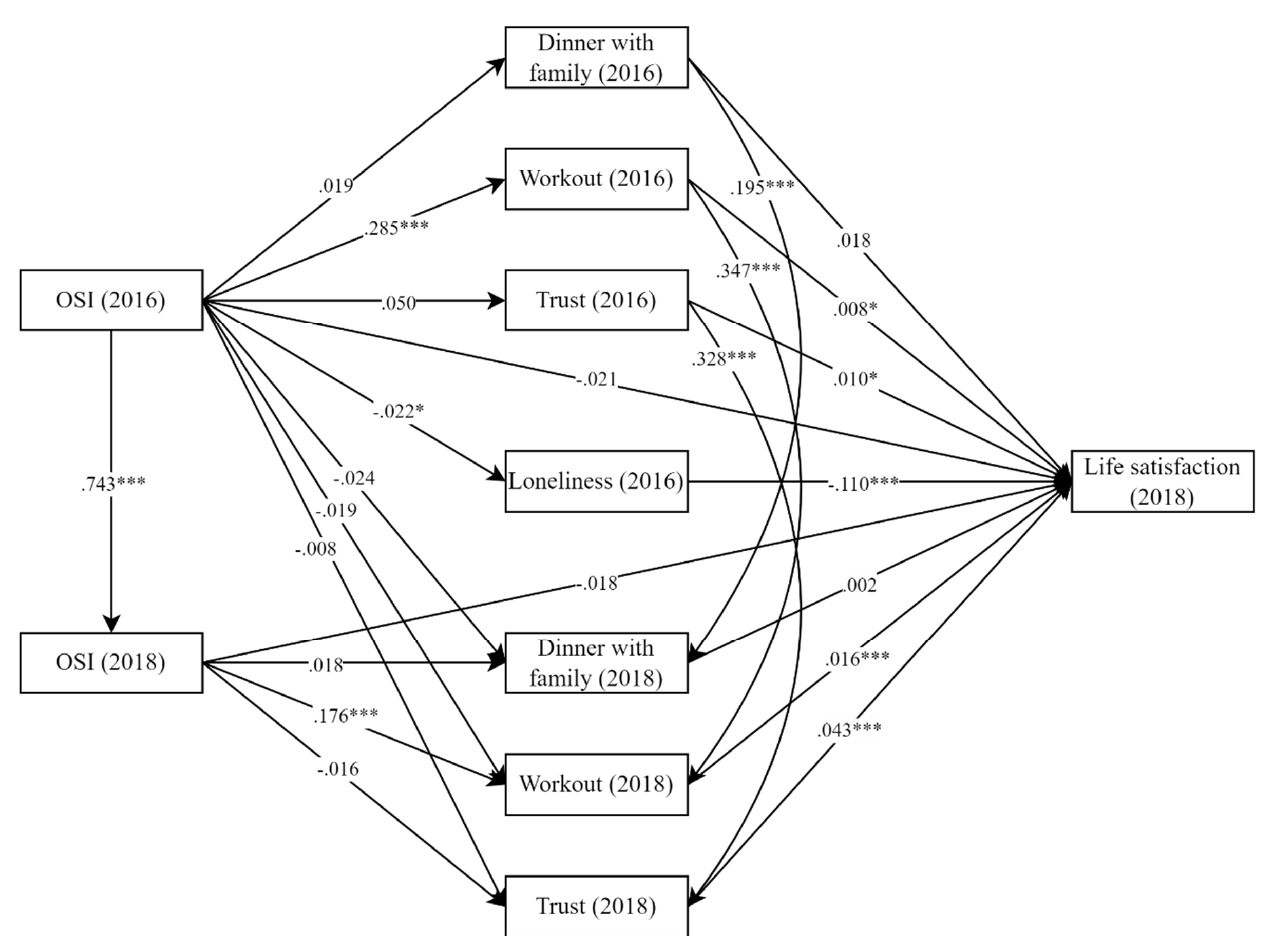
Figure 4. Lagged cross-mediation model with 2018 CFPS but lagged OSIs and mediators. Note: Model coefficients reported in the path diagram are standardized, and for brevity, the main paths of interest are reported, and other controls include rural/urban residential status, gender, age, and marital status. Robust model fit indices: n = 4637, χ² = 126.2, df = 22, CFI = 0.977, TLI = 0.916, RMSEA = 0.032, SRMR = 0.016. * p < 0.05, *** p < 0.01.